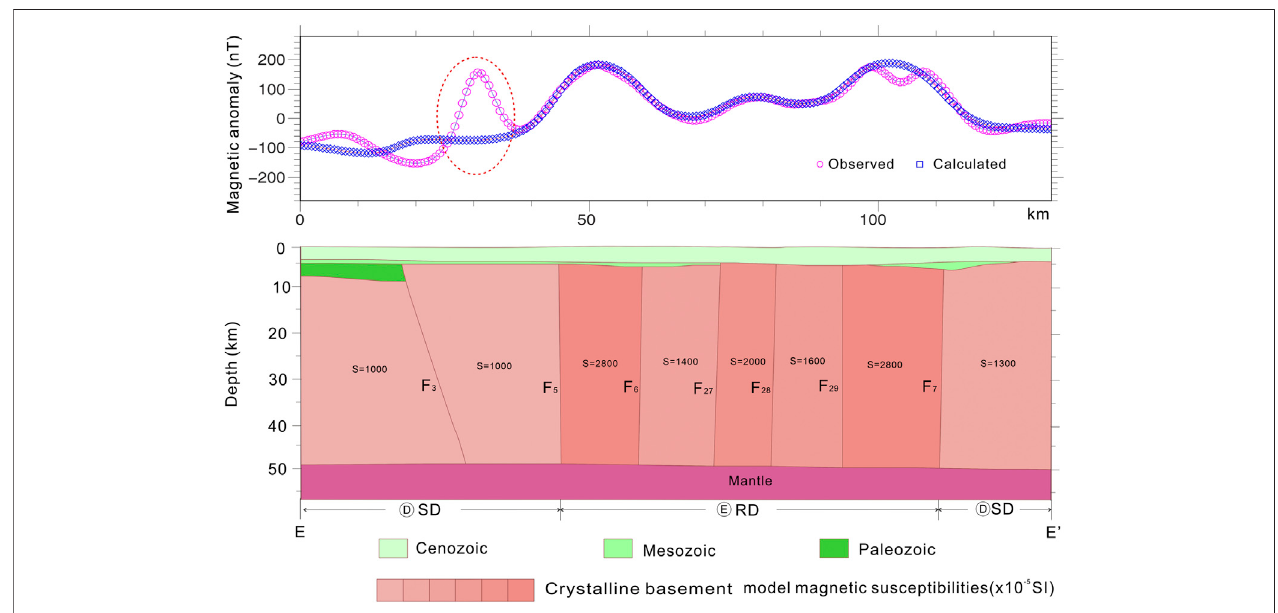
FIGURE 11 | Pro fi le EE ′ for magnetic forward modeling, pro fi le location showed in Figure 3A . The observed high-frequency magnetic anomaly labeled with a dotted line ellipse may be the response of magmatic rock. See Figure 7 for other fi gure descriptions.